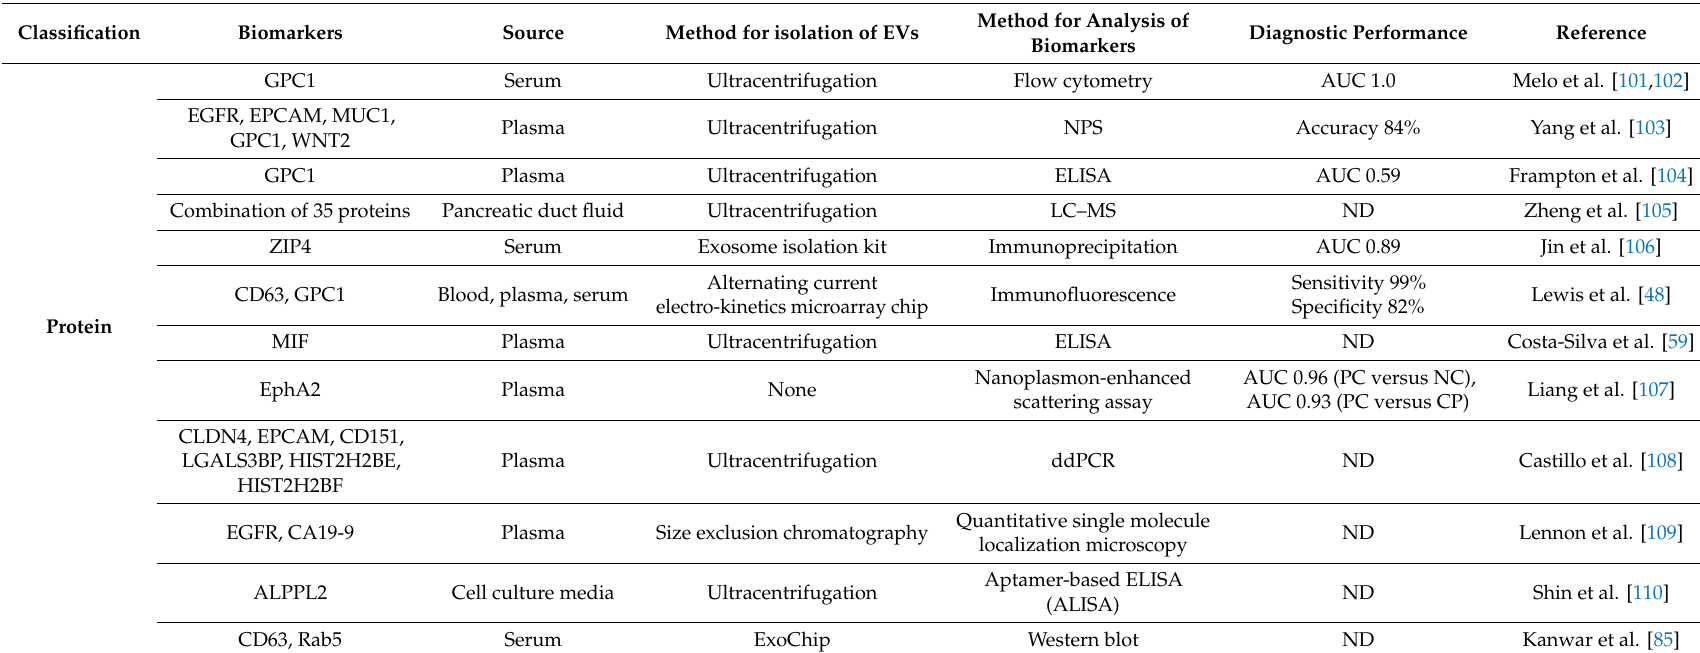
Table 4. Panels of EV protein biomarkers for early detection and diagnosis of pancreatic